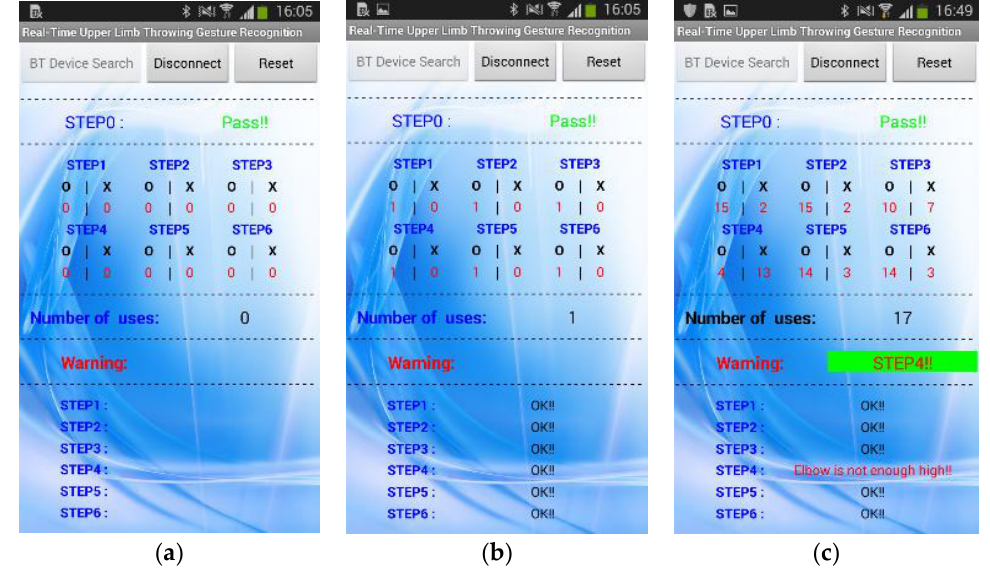
Figure 17. Mobile phone interface displaying: ( a ) status of Step 0; ( b ) throwing action data statistics for correct upper extremity throwing action; ( c ) throwing action data statistics for incorrect upper extremity throwing action.